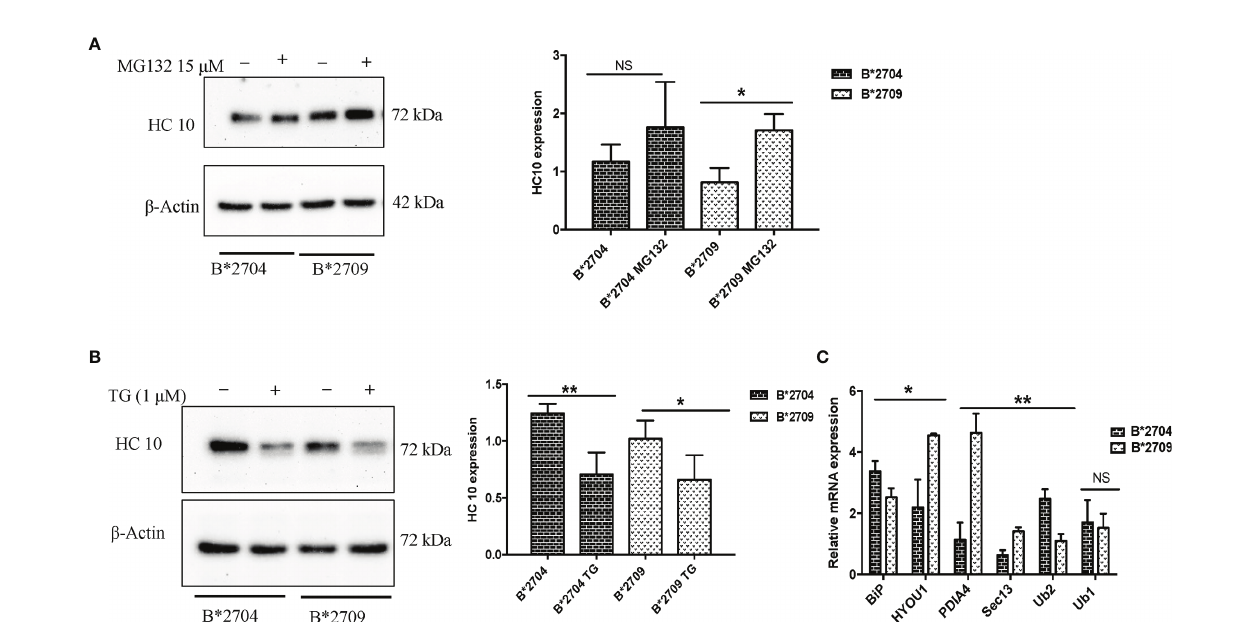
FIGURE 7 | Stable transfectants of pEGFP-HLA-B27 subtypes (B*2704 and B*2709), untreated ( − or UT), or treated with MG132 (+) (A) or thapsigargin (B) . The blots were probed with HC10. Actin levels were probed to serve as loading control for all samples and allow normalization of the signals. In each panel, histograms show densitometry data (mean ± SD) from 3 experiments corresponding to the Western blotting, using ImageJ software. Real-time PCR was carried out for expression of UPR markers, BiP, ubiquilin-1 and ubiquilin-2, and vesicle transport markers HYOU, PDI, and SEC13 (C) . Histogram shows data (mean ± SD) from 3 experiments for each marker. NS, non signi fi cant (p > 0.05); *p < 0.05; **p < 0.01.